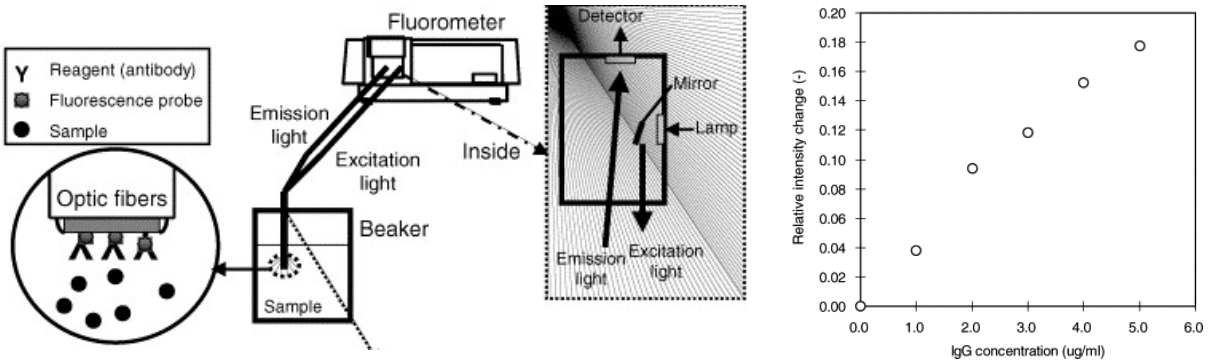
Figure 13. a) Schematic diagram of the reagent-less fiber-optic fluorescent immunosensor. b) Typical relationship between the IgG concentration and the fluorescence intensity change of QD-protein A on a glass plate [149]. Reproduced from Biosensors and Bioelectronics, 20, Satoka Aoyagi and Masahiro Kudo, Development of fluorescence change-based, reagent-less optic immunosensor, 1680-1684, Copyright (2005), with permission from